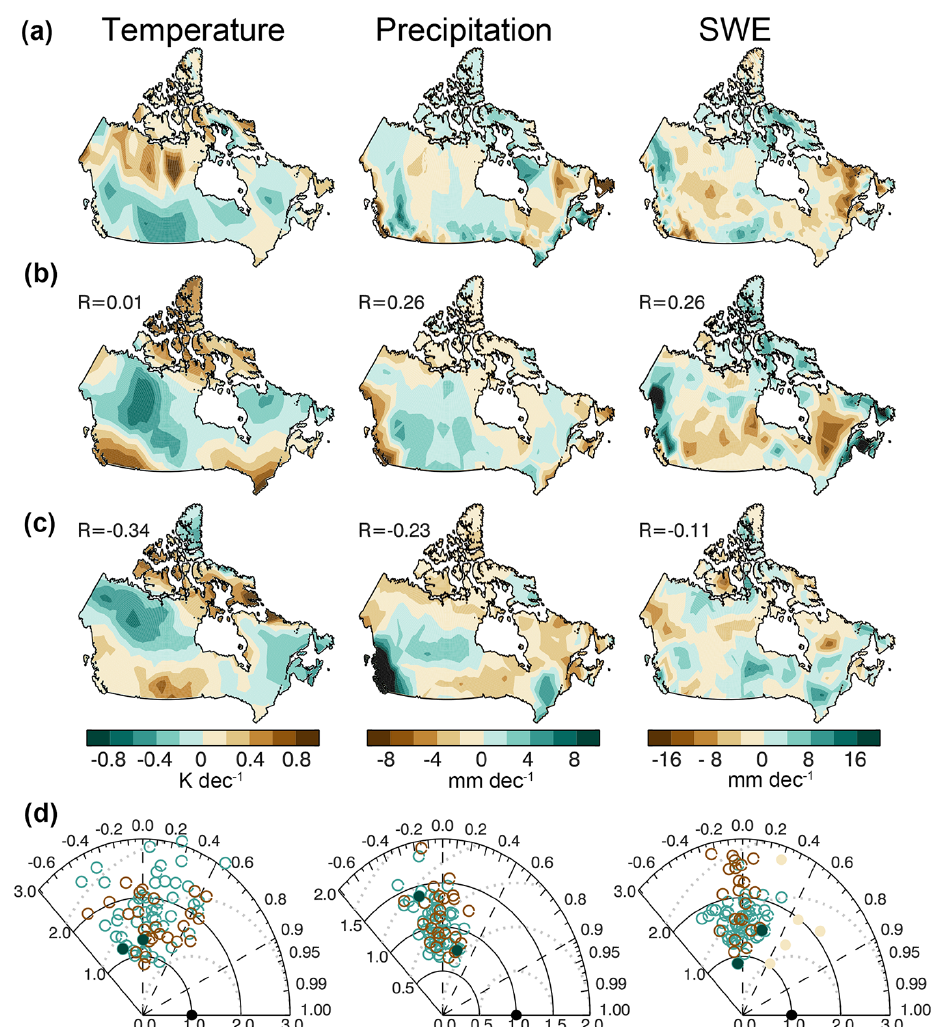
Figure 5. Panel (a) shows the observed 1981–2005 trend over Canada in JFM land-surface temperature, precipitation, and SWE, with the spatial mean of the trend removed, based on the same observational datasets represented in Figs. 1 and 2. Panel (d) shows the Taylor diagram of individual realizations of CanESM2 (teal) and CMIP5 (brown). The Taylor diagram for SWE also includes individual Blended-5 observations (light brown). Panels (b) and (c) show the land-surface temperature, precipitation, and SWE trends for the best match and worst match realizations as defined in the text. The best and worst match realizations are shown as filled circles in the Taylor diagrams. Note that the realizations represented are the same in this figure and in Fig.